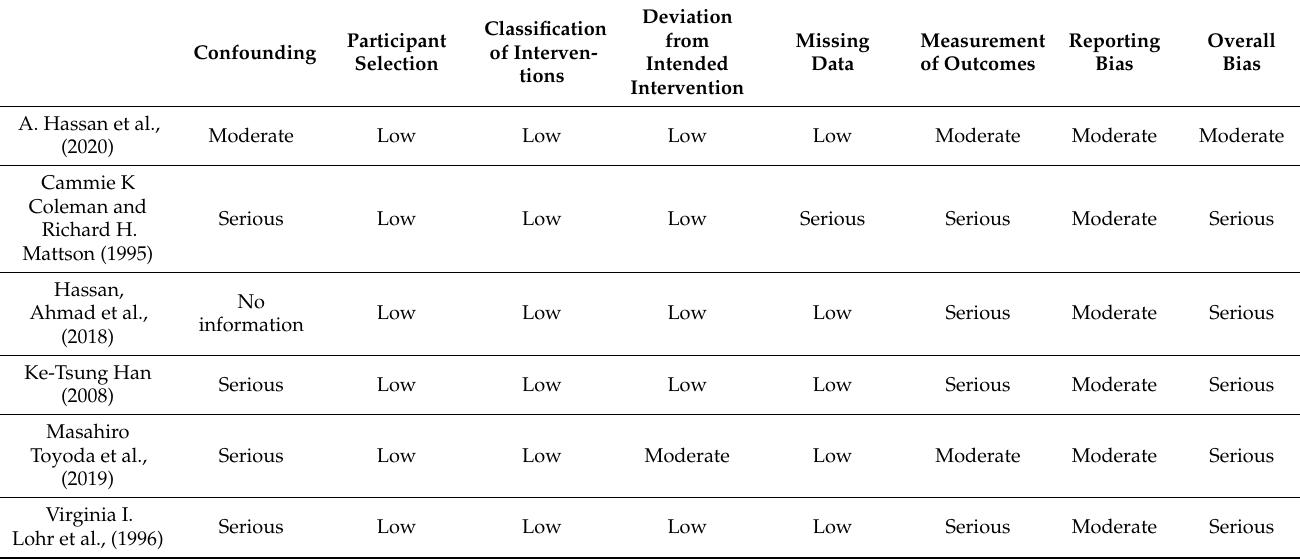
Figure A2. Risk of Bias graph for included RCT studies. Table A1. ROBINS-I assessments.